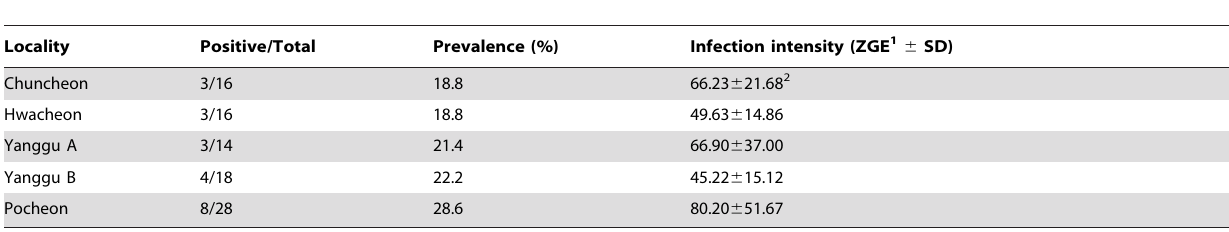
Table 3. Prevalence and infection intensity as determined in the field by zoospore filtering method.